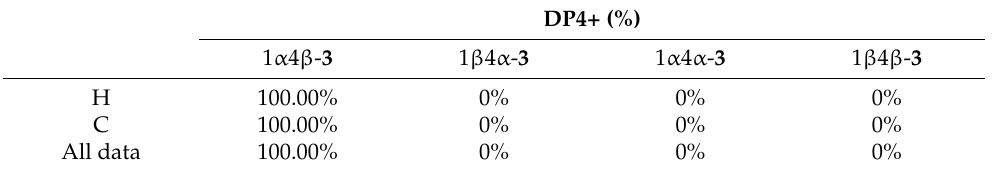
Table 3. DP4+ probabilities for possible isomers of compound 3 .